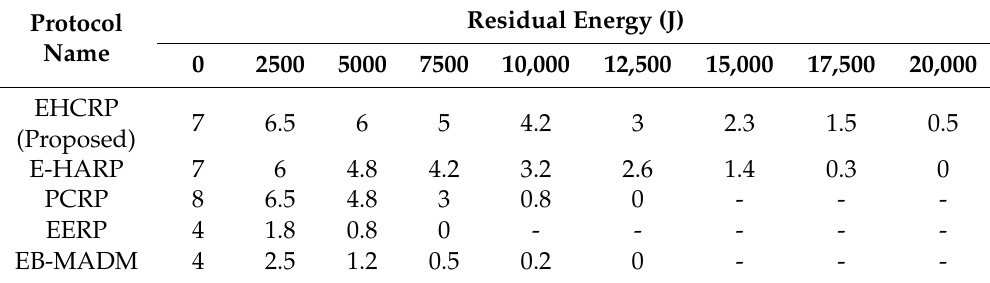
Table 7. Network throughput vs. time (s).